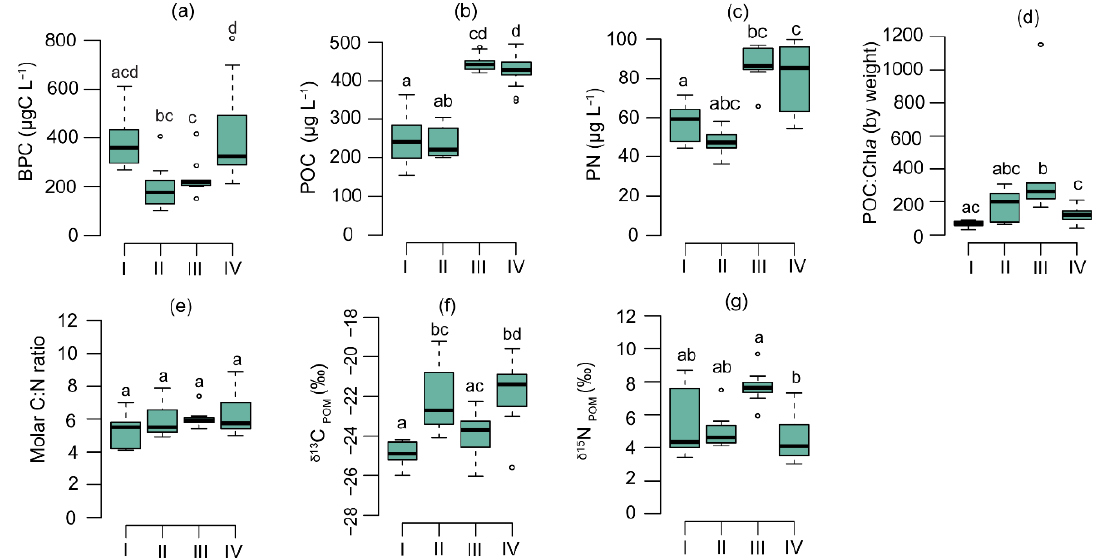
Figure 5. Box and whisker plots showing ( a ) biopolymeric carbon (BPC), ( b ) particulate organic carbon (POC), ( c ) particulate nitrogen (PN), ( d ) POC:Chl a ratio, and ( e ) C:N ratio; as well as isotopic compositions of particulate organic matter (POM) (( f ), δ 13 C POM ; and ( g ), δ 15 N POM ) of four clusters. The median value of each cluster is indicated by the horizontal bar inside the box. The same superscripts within each panel indicate statistically nonsignificant differences between clusters ( p >